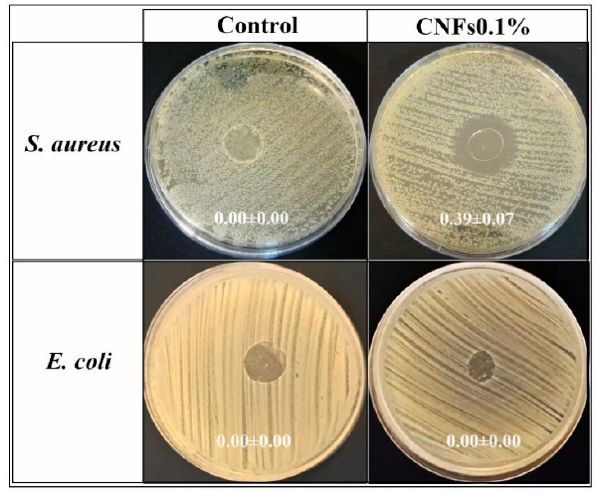
Figure 3. Representative titration plaques of bacteriophage T4: antiviral tests of alginate films and alginate/carbon nanofibers films (CNFs0.1%) at 10 min, and 18 and 48 h of contact with the virus.